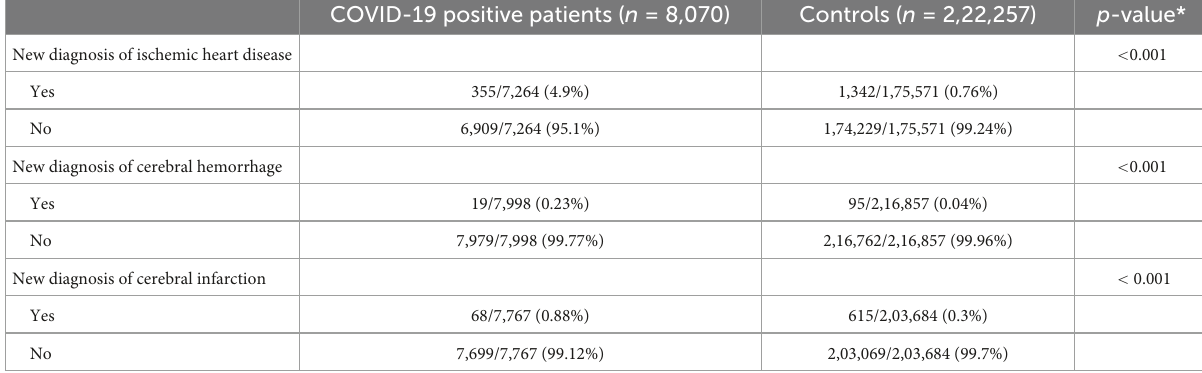
TABLE 1 New diagnosis of cardio-cerebrovascular complications among the COVID-19- positive cases and controls. COVID-19 positive patients ( n = 8,070) Controls ( n = 2,22,257)